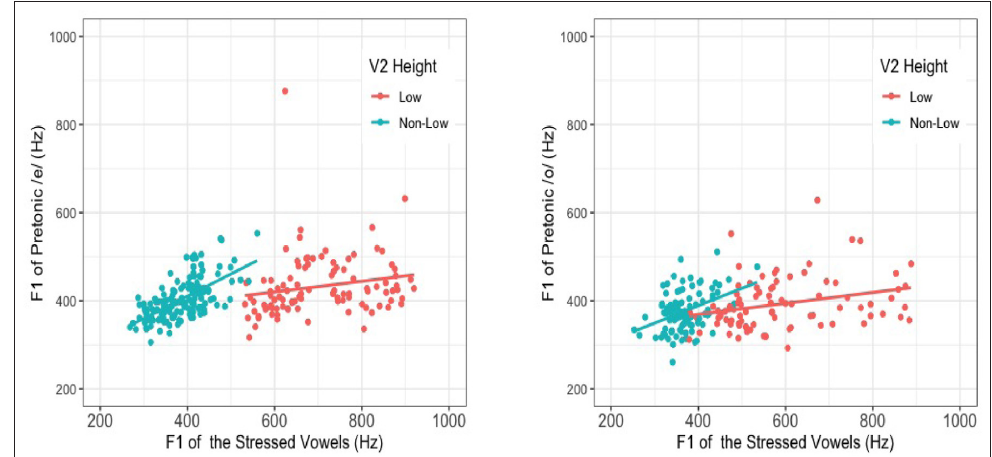
Figure 6: Correlation between stressed F1 (Hz) and pretonic F1 (Hz) for tokens produced by Sou-D speakers, with pretonic /e/ on the left, and pretonic /o/ on the right. Red dots = low stressed vowels, green dots = non-low stressed